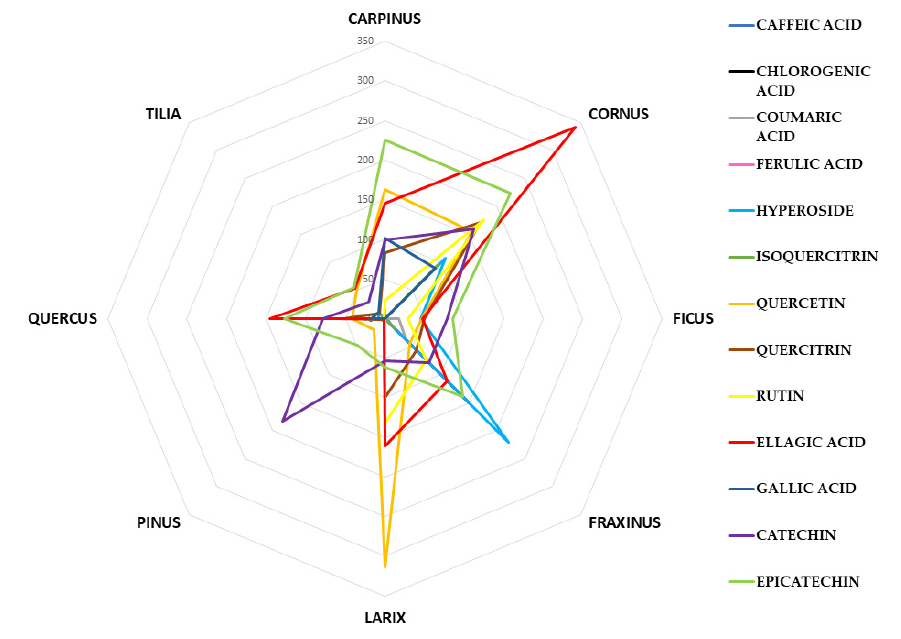
Figure 6. The mean content of each phenolic marker (caffeic acid, chlorogenic acid, coumaric acid, ferulic acid, hyperoside, isoquercitrin, quercetin, quercitrin and rutin, ellagic acid, gallic acid, (+)catechin and (-)epicatechin) for the eight botanical species investigated.